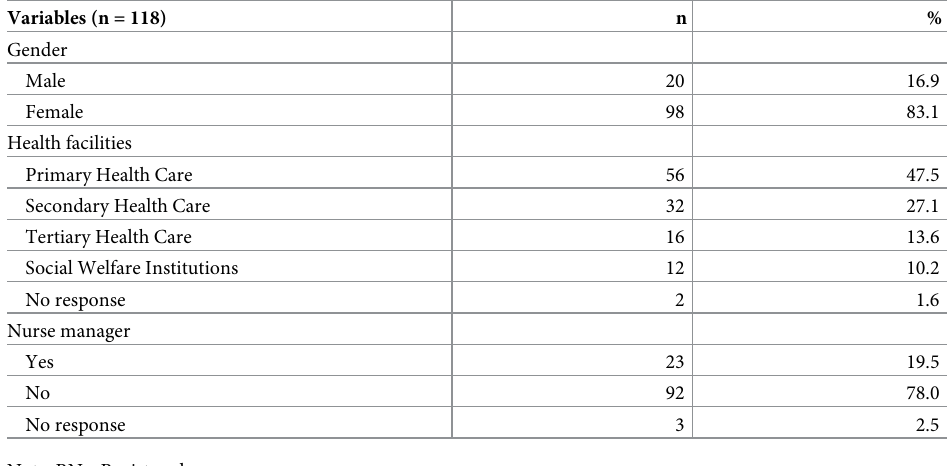
Table 1. Demographic data concerning the